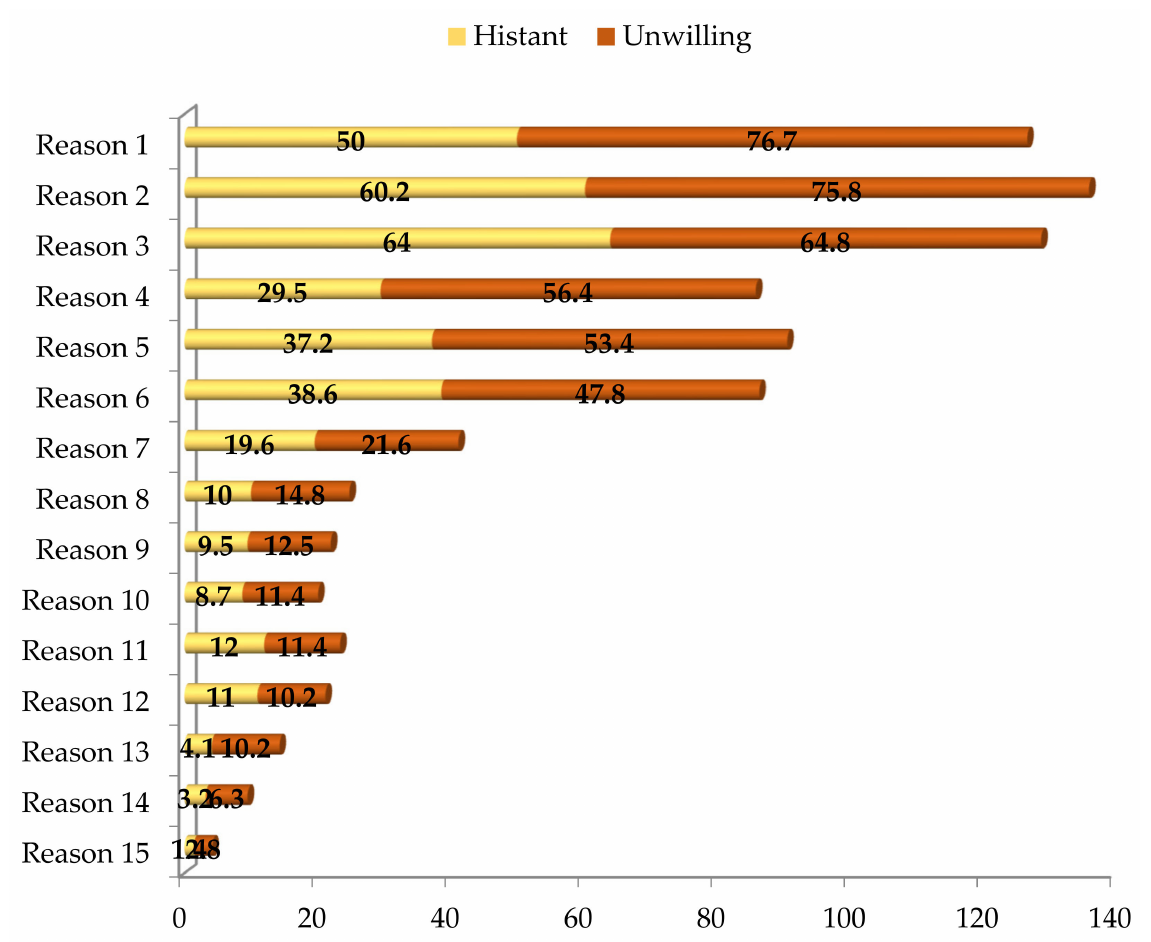
Figure 3. Reasons made parents hesitate or unwilling to vaccinate their children aged from 5 to under 12 years (measured in percentage). Note. Reason 1 = concern about side effects, Reason 2 = con- cern about the probability that their children might suffer from myocarditis and pericarditis, Reason 3 = concern about the long-term impact of COVID-19 vaccine on children’s fertility, Reason 4 = concern that the current vaccines cannot protect their children from new variants/sub- variants, Reason 5 = the vaccines are developed for adults, Reason 6 = concern that vaccinated children can still be infected, Reason 7 = the number of cases in the community is decreasing, Reason 8 = the number of deaths caused by the virus in the community is decreasing, Reason 9 = there has not been sufficient information on the vaccines, Reason 10 = there has not been sufficient information on the number of cases and deaths caused by the virus among chil- dren, Reason 11 = the impact of infection in children is less severe than in adults or adolescents, Reason 12 = children have lower probability of being infected with the virus than adults or ado- lescents, Reason 13 = my children have been infected with the virus and no need to vaccinate, Reason 14 = my children had comorbidities, Reason 15 = my children had vaccine reaction history. Source. Illustrated by the authors using surveyed